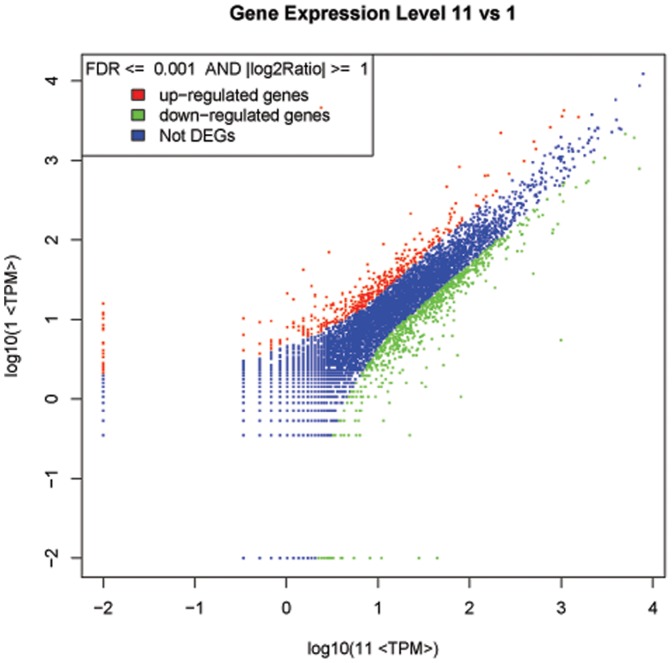
Comparison of gene expression between libraries of deformed and normal beak RNA.Blue dots represent the transcripts with no significant differential expression. Red and green dots represent transcripts more abundant in the test sample and control, respectively. FDR <0.001 and |log2-Ratio| ≧ 1 were used as the thresholds to judge the significance of gene expression difference.